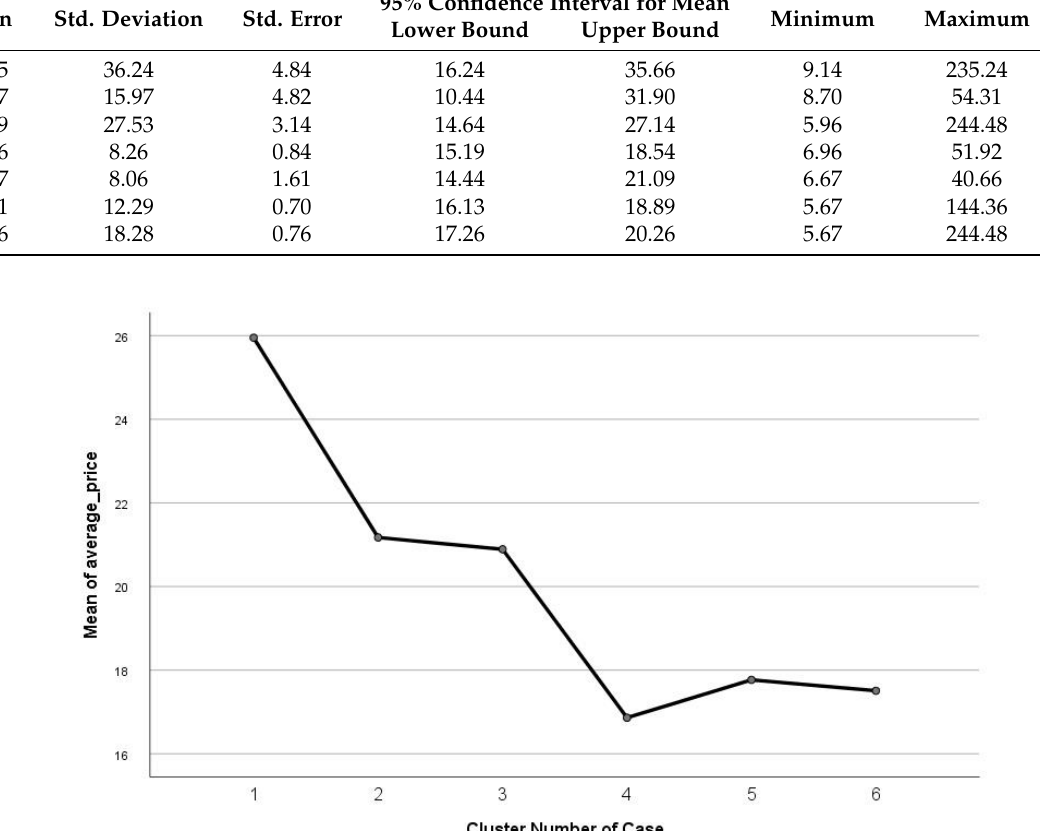
Figure 2. K-means clustering of words used to describe winery brand identity on the winery’s website. Table 5. Bottled wine prices for six brand identity clusters. Table 4. Analysis of variance for the six wine brand identity clusters regarding average price of bottled wine.